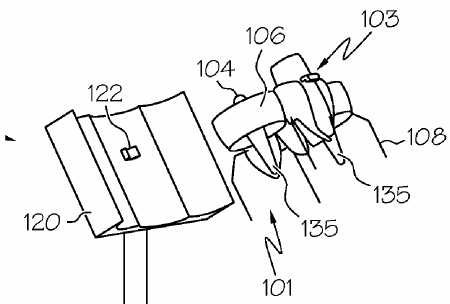
Figure 42. UAV launch and landing system [98] by Honeywell International Inc. 101, UAV; 120, capture plate; 122, carrying bracket.